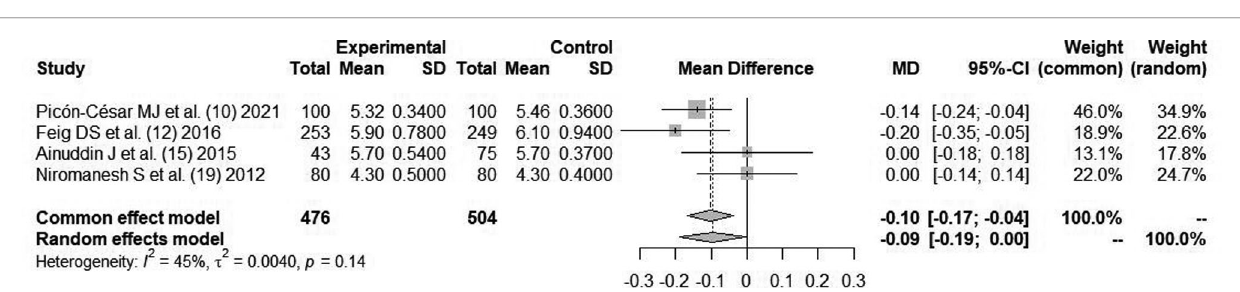
FIGURE 4 | Comparison of postpartum glycosylated hemoglobin (HbA1c postpartum) after glycemic control during